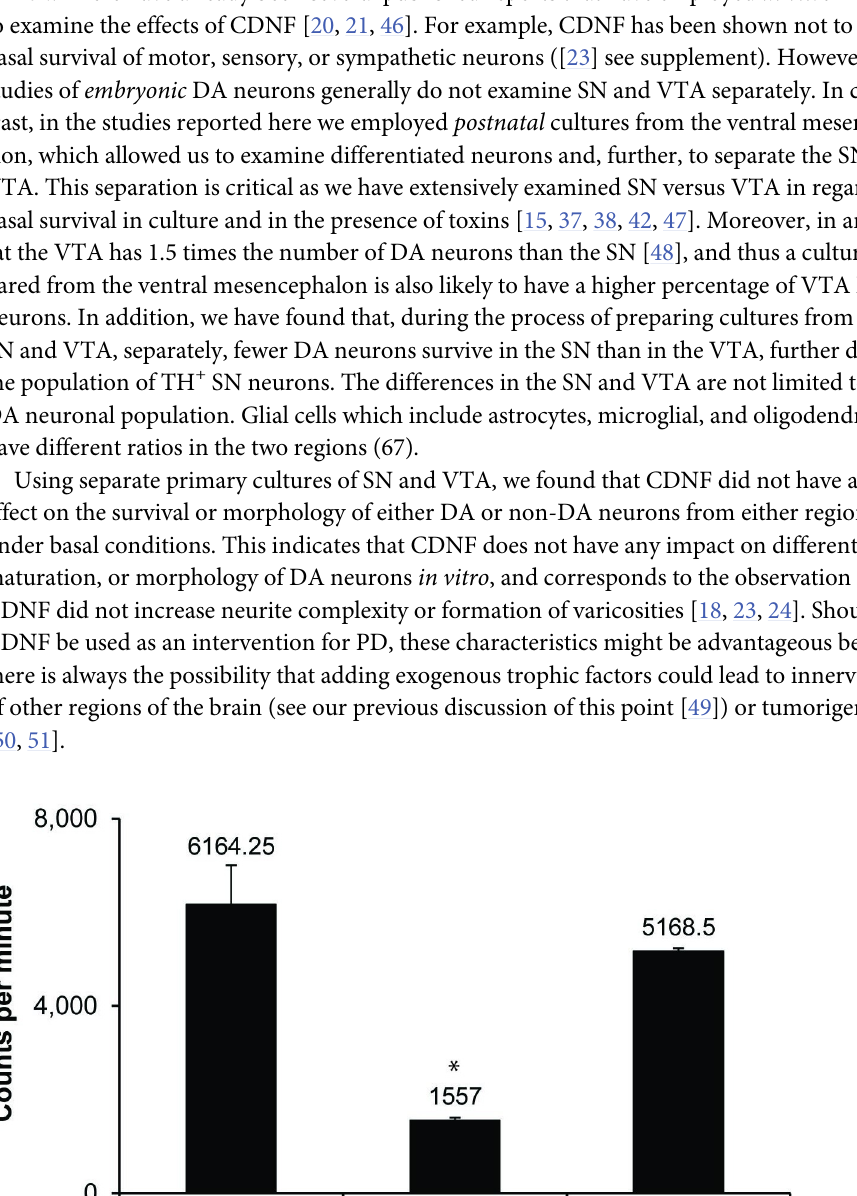
Fig 4. Protection by the combination of CDNF and N4 of DA neurons and indicated by TH isolated from the VTA. NTFs were added 1 hr prior to the addition of 1 mM MPP + and for 48 hrs thereafter at concentrations of (A) 100 ng/ml and (B) 200 ng/ml in cultures isolated from the VTA. The combination of CDNF and N4 significantly increased survival of DA neurons ( � p < 0.05, two-way ANOVA followed by post hoc test with Bonferroni correction on the cell count, n = 6–7 experiments). (C) 500ng/ml of CDNF and/or N4 did not increase survival but did cause some but not significant basal cell loss.